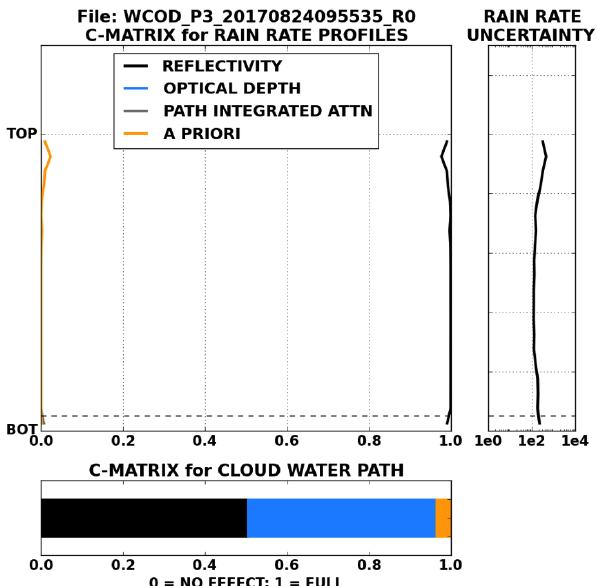
Figure 3. Mean contribution matrix (or C matrix) calculations rela- tive to cloud height for the radar profiles shown in Fig. 2. The C ma- trix for each retrieved rainfall rate, as well as CWP, was calculated according to Eq. (13). Individual C-matrix profiles are normalized to the full length of the reflectivity profile (i.e., 0: radar echo base, 1: radar echo top). Data below the dashed line indicate a C-matrix calculation for both the surface (i.e., corrected for evaporation) and near-surface precipitation rates and are exactly the same for both precipitation rate quantities. In the bottom panel, the contributions from reflectivity, optical depth, PIA, and a priori uncertainties are respectively shown in black, blue, gray, and orange.